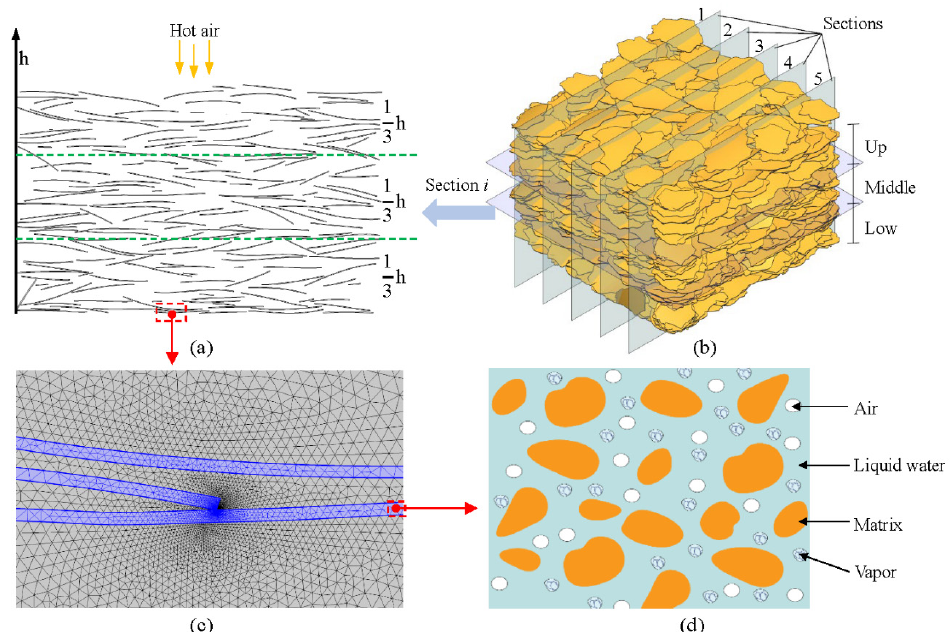
Figure 2. Simplification, grid, and representative elementary volume of heaped tobacco strips model. ( a ) 2D cross-section of 3D model; ( b ) 3D model and division principle; ( c ) grid in contact area; ( d ) representative elementary volume with different phases.